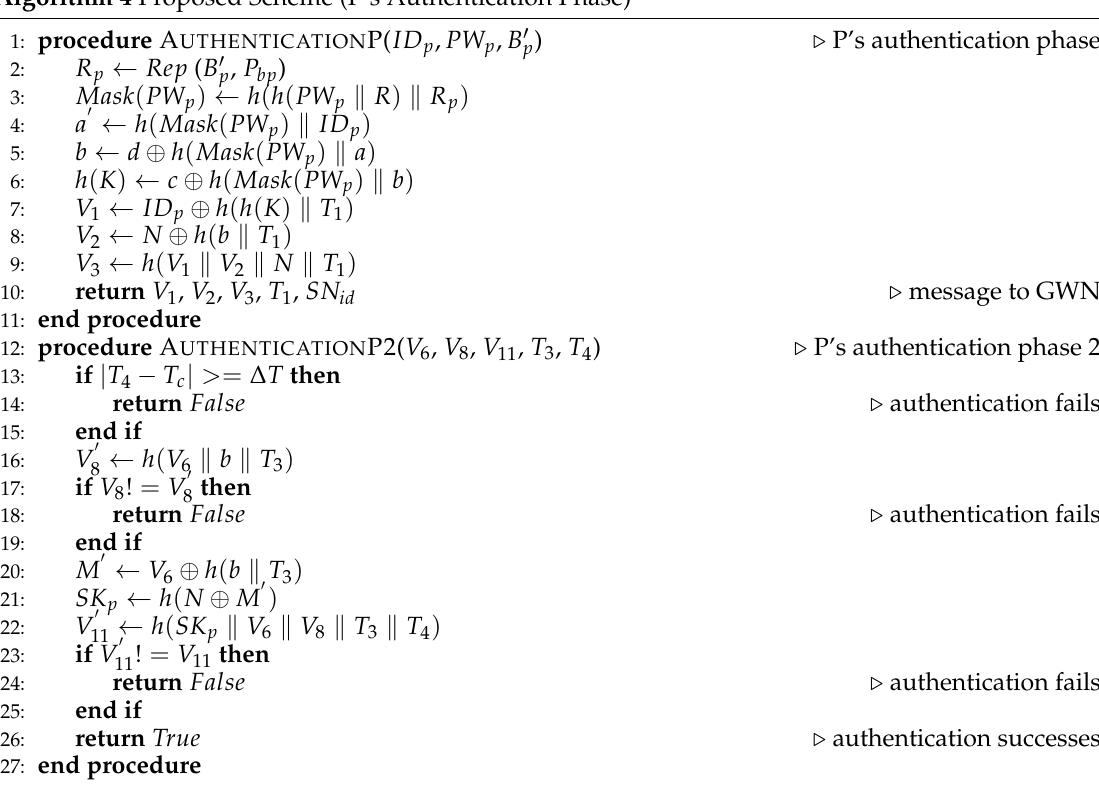
Algorithm 4 Proposed Scheme (P’s Authentication